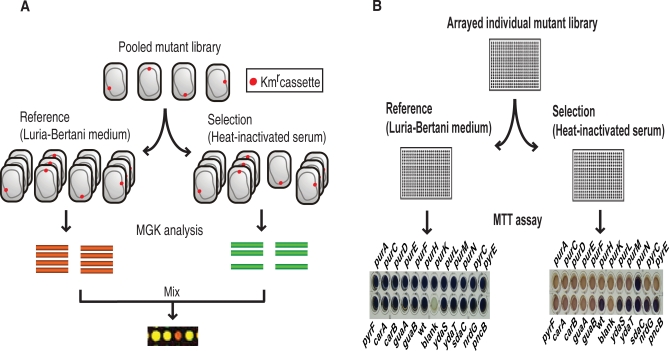
Identification of Genes Required for the Growth of E. coli in Human Serum(A) Schematic representation of the identification of E. coli mutants from the Keio library with a growth defect in human serum using Monitoring of Gene Knockouts (MGK).(B) MTT dye-based screening for mutants with a growth defect in human serum. MTT was added after 24 h of growing the arrayed mutant library in 96-well plates in either LB medium or serum. Mutants that could grow in serum generated a deep blue color by reducing MTT. The lack of a blue color in a serum bacterial culture served as a qualitative indicator of the inability of that mutant to grow in serum.